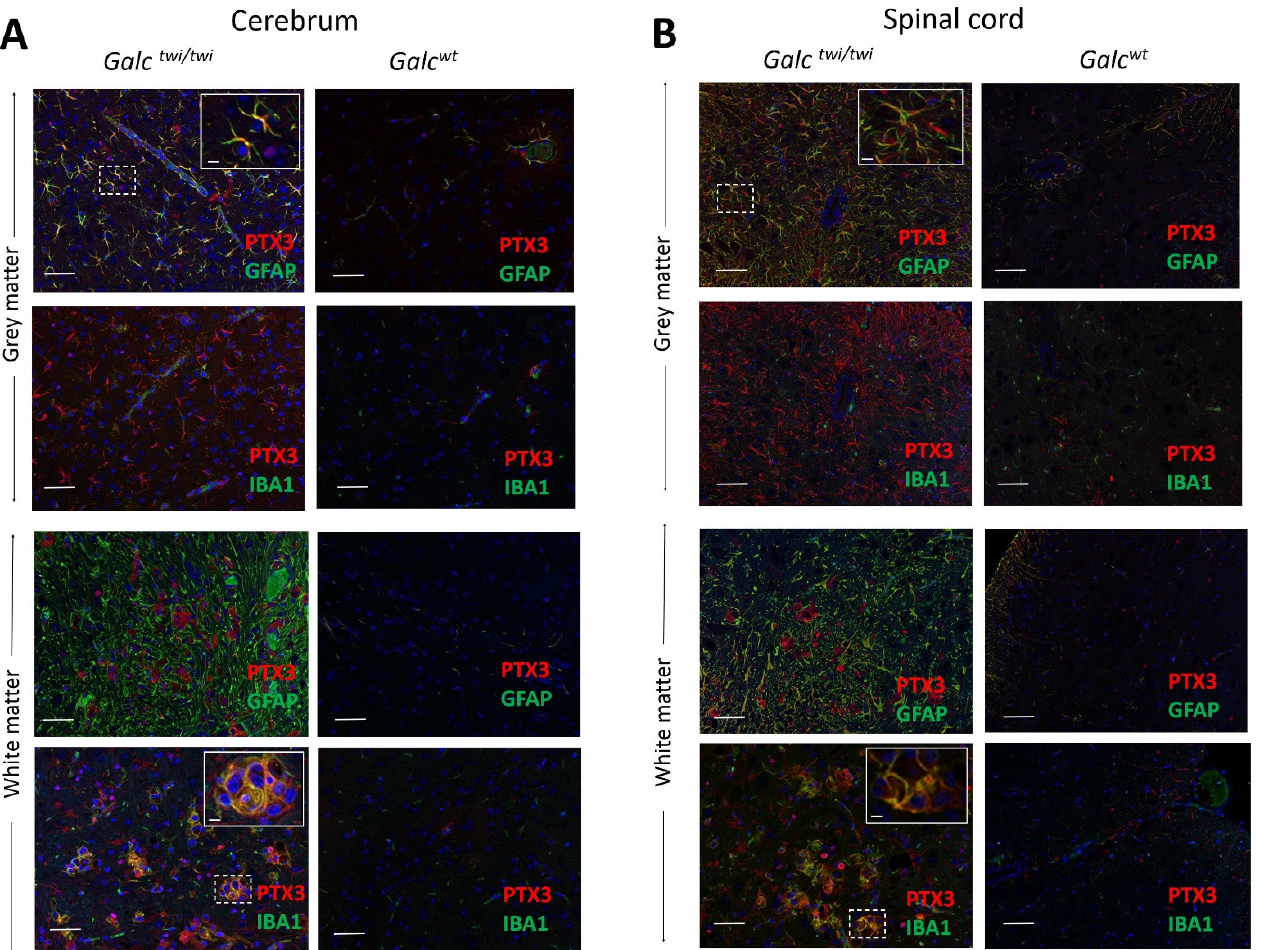
Figure 4. PTX3 immunolocalization in the CNS of twitcher mice. Paraffin-embedded sections of the white and gray matter of the brain cortex ( A ) and spinal cord ( B ) of P35 Galc twi/twi mice were double-immunostained with anti-PTX3/GFAP or anti-PTX3/IBA1 antibodies. Inserts show enlarged areas marked by dashed squares. Scale bar, 50 µ m; scale bar in inserts, 5 µ m.